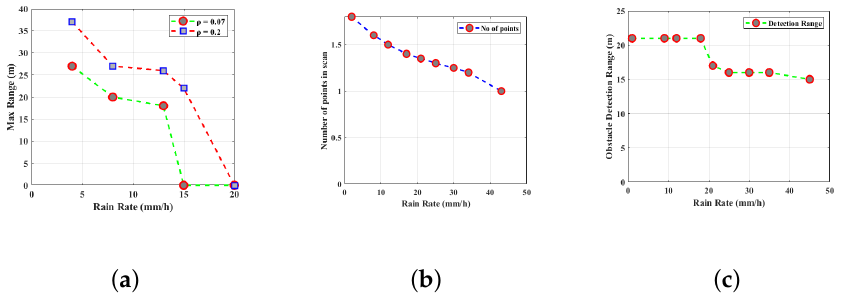
Figure 6. ( a ) Max range influenced by rain rate ( b ) Number of points influenced by rain rate ( c ) Obstacle detection range influenced by rain